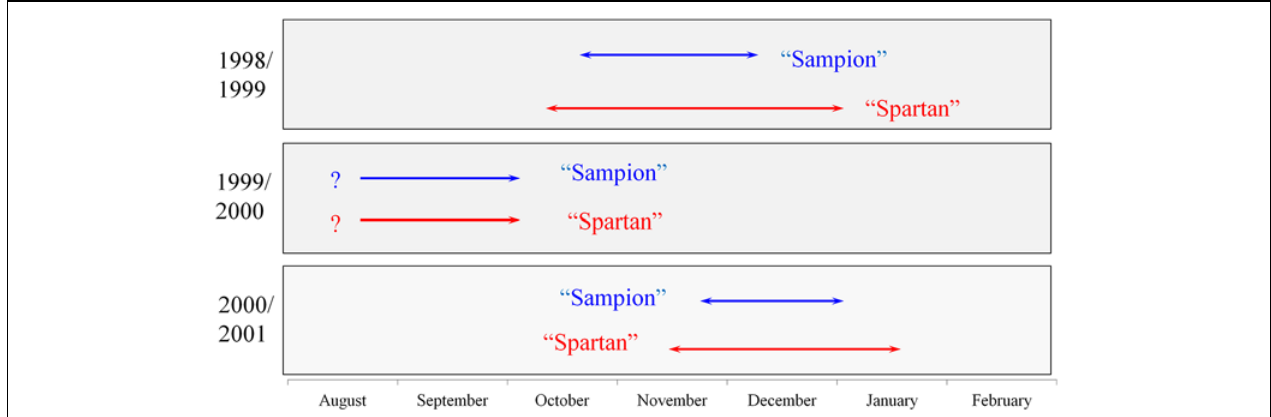
FIGURE 3 | Scheme of endodormancy of vegetative buds of apple cultivars ‘Sampion’ and ‘Spartan’ in the seasons of 1998/1999, 1999/2000, and 2000/2001. The length of arrows corresponds to the length of endodormancy. The question mark indicates unknown length of endodormancy in the season of 1999/2000.